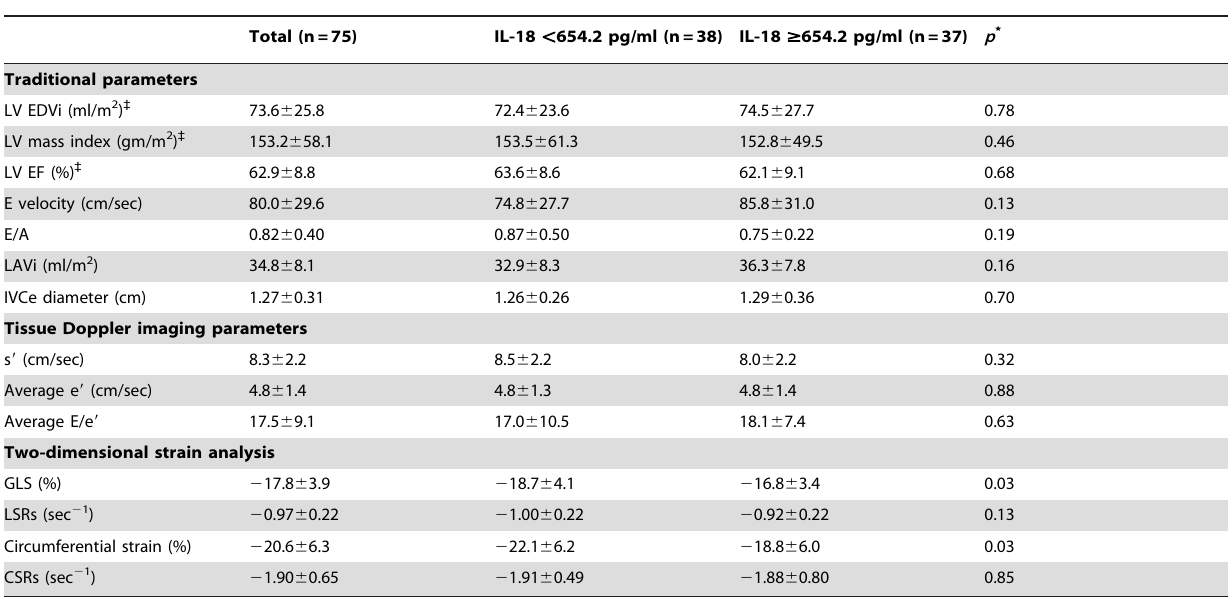
Table 2. Echocardiographic study results of stable hemodialysis